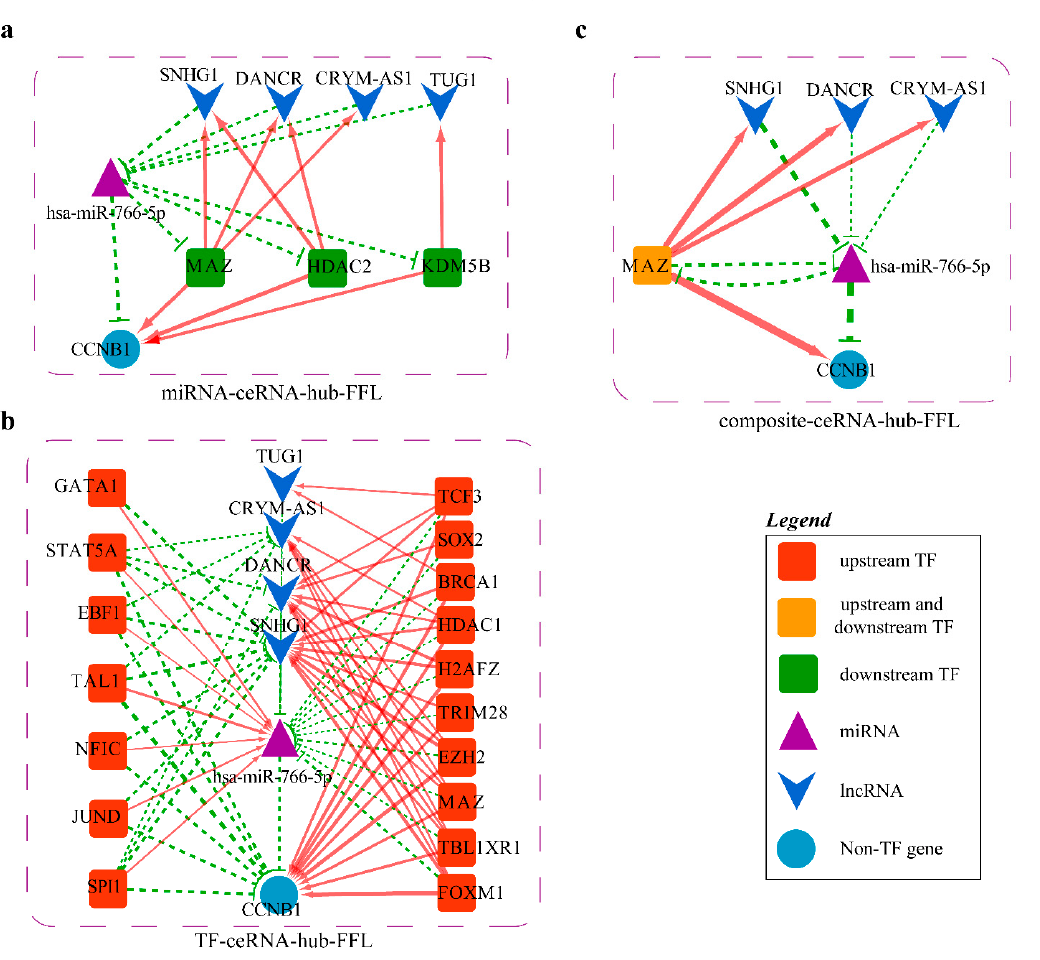
Figure 17. MiR-766-5p related ceRNA-hub-FFL network: ( a ) MiR-766-5p related II-FFL network; ( b ) MR-766-5p related I-FFL network; ( c ) MiR-766-5p related III-FFL network. Green dashed line indi- cates inhibition, while red indicates activation and line thickness indicates the strength of correla- tion.